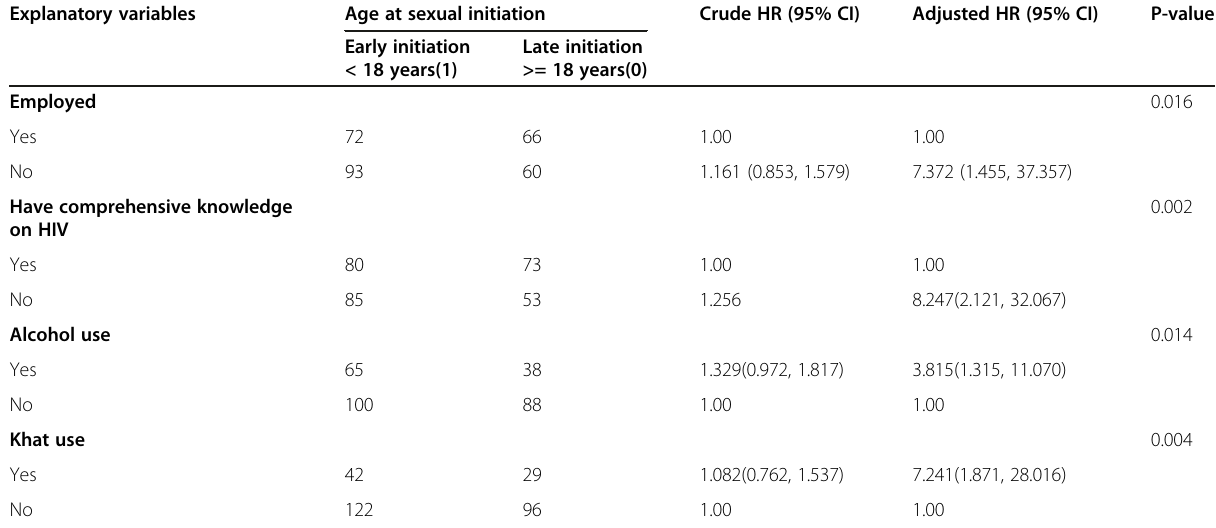
Table 3 Predictors of early sexual initiation among youths (Crude & adjusted HR) in Gamo-Gofa, South West Ethiopia,